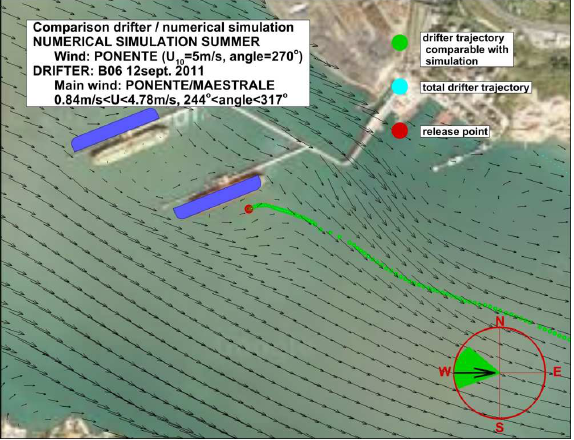
Fig. 13. Qualitative comparison of the numerical flow field, black vectors, with respect to the drifter trajectory, green dots, for the Maestrale scenario.